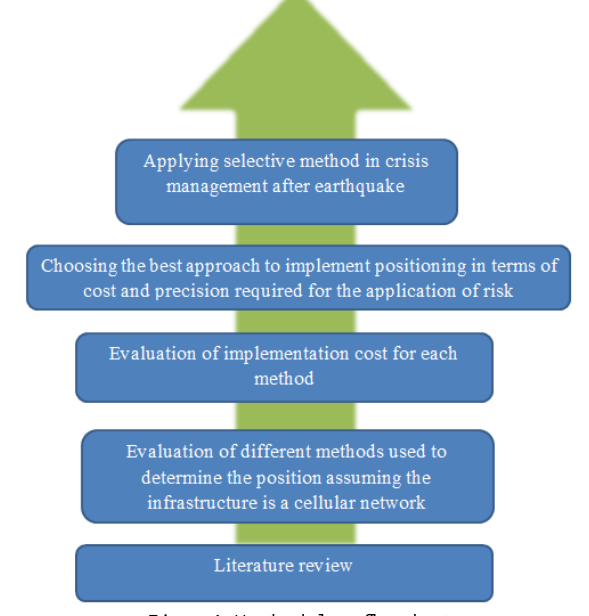
Figure 1. Methodology flowchart